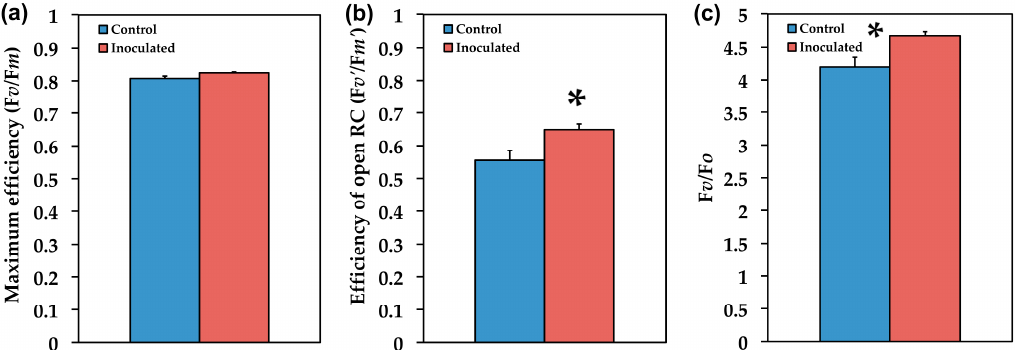
Figure 6. The maximum efficiency of PSII photochemistry (F v /F m ) ( a ), the efficiency of open PSII reaction centers (F v ‘/F m ‘) ( b ), and the efficiency of the water-splitting complex on the donor side of PSII (F v /F o ) ( c ), of Salvia fruticosa leaves from control (non-inoculated) and inoculated plants. Error bars on columns are standard deviations (n=6). An asterisk (*) represents a significantly different mean between the two treatments by Student’s t-test at a level of p< 0.05.